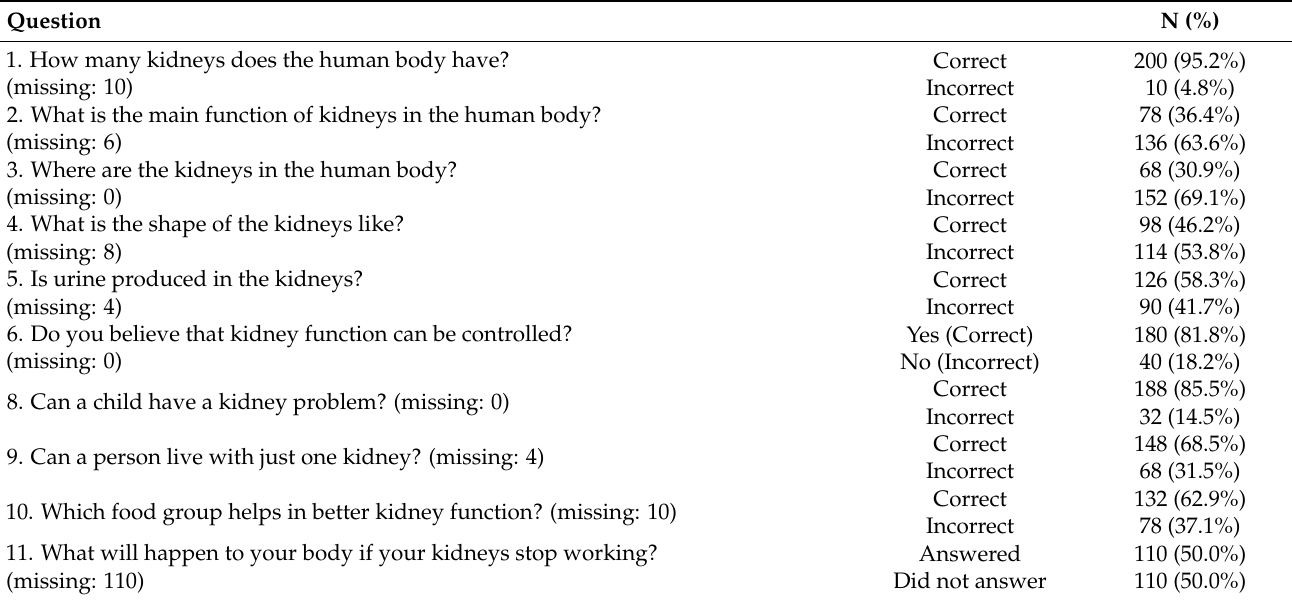
Table 1. Description of the answers regarding student’s knowledge—perception of the importance of the kidneys for good physical